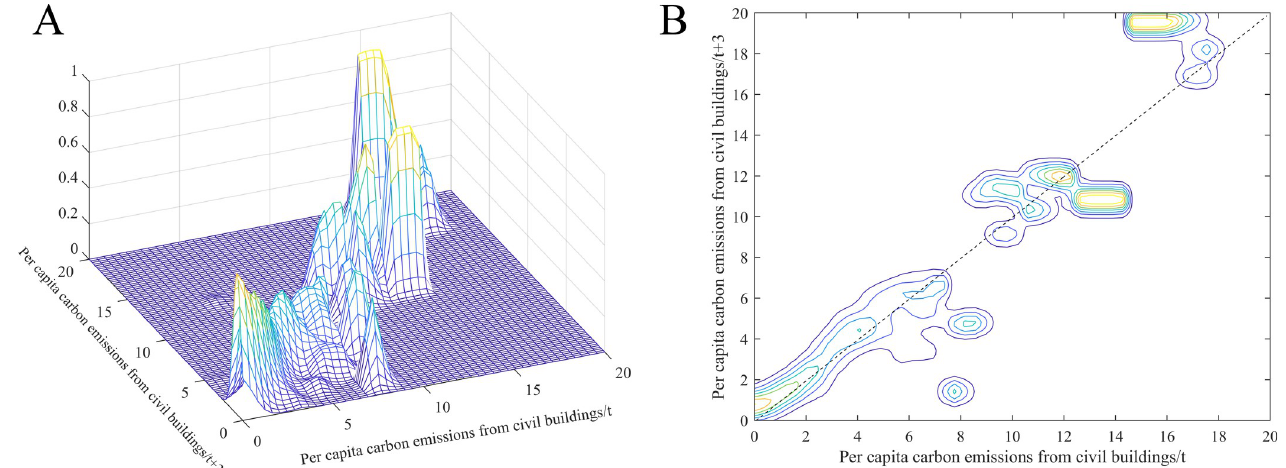
Fig 6. Dynamic stochastic kernel density curve (A) and density contour (B) of per capita carbon emissions from civil buildings.